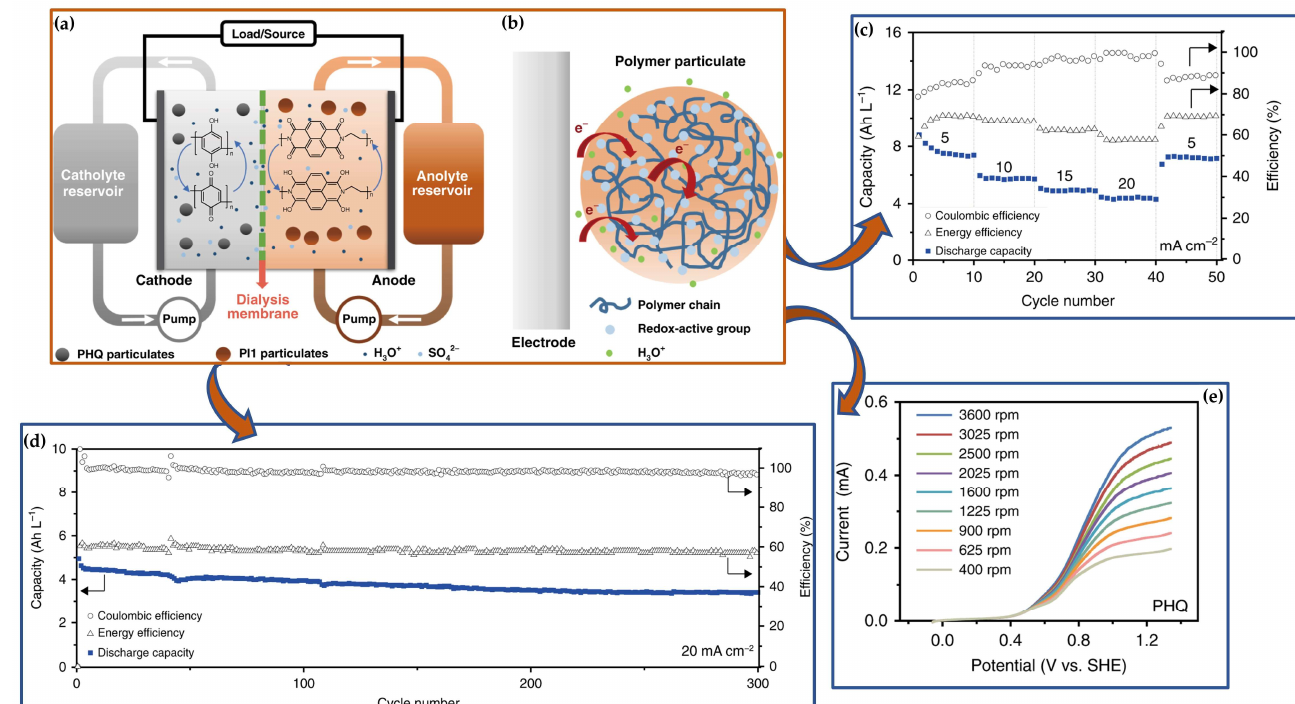
Figure 11. Organic slurry RFB based on all polymer particulate suspension reported by Yan et al. [274]. ( a ) Schematic representation of the mentioned organic slurry RFB. ( b ) Illustration of the proposed kinetic mechanism to elucidate the charge transfer particulates in the redox processes. ( c ) The capacity, coulombic efficiency, and voltage efficiency in a galvanostatic charge–discharge cycle for current densities from 5 mA cm −2 to 20 mA cm −2 . ( d ) Representation of the long-term stability during charge–discharge cycles at 20 mA cm −2 . ( e ) Representation of the polarization curves for different flowrates. Copyright 2019, Springer Nature.